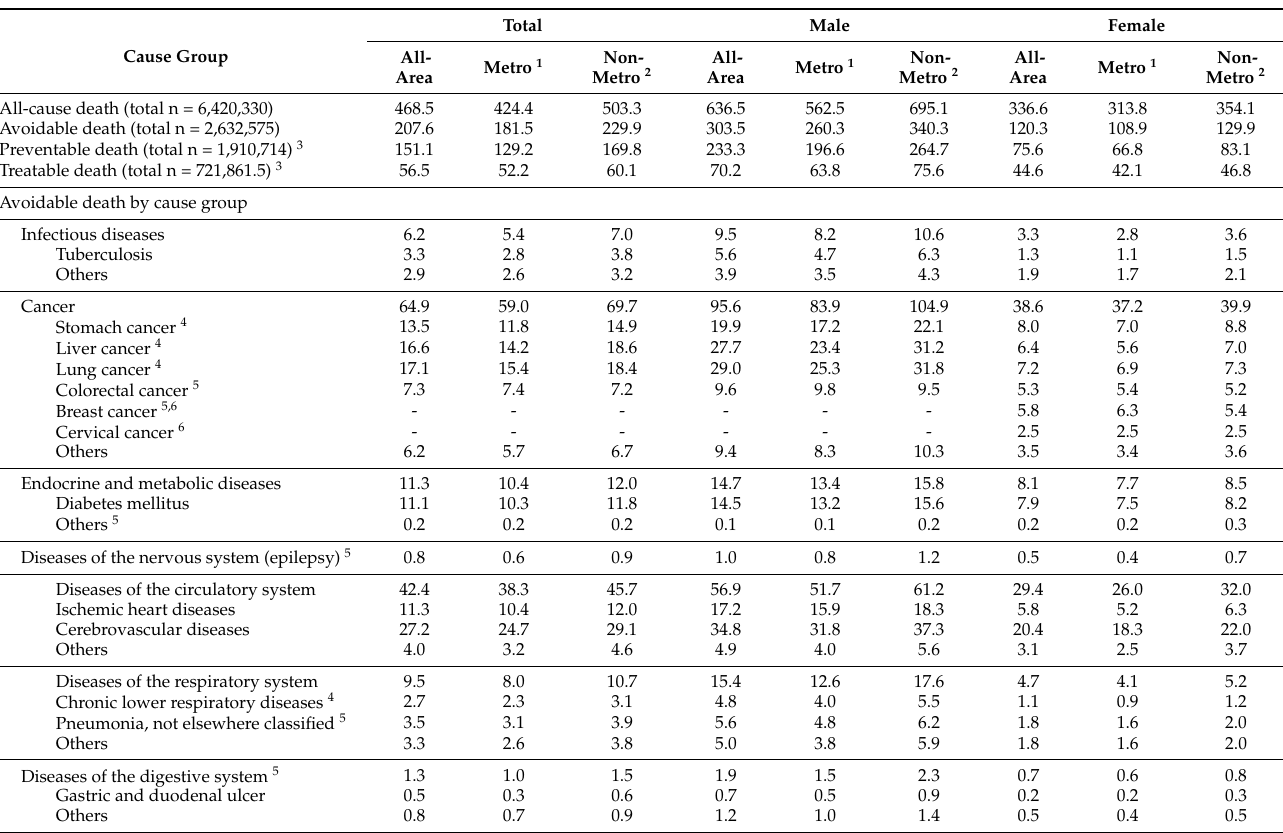
Table 1. Age standardized all-cause and avoidable mortality rates (per 100,000 persons) according to cause in groups by the type of areas in South Korea from 1995 to